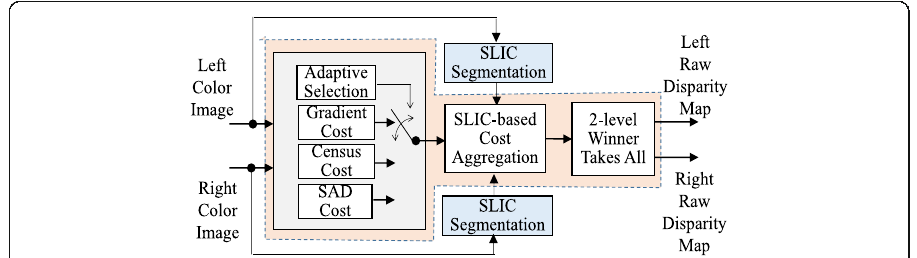
Fig. 5 Diagram of the adaptive stereo matching computation unit to estimate left and right raw disparity